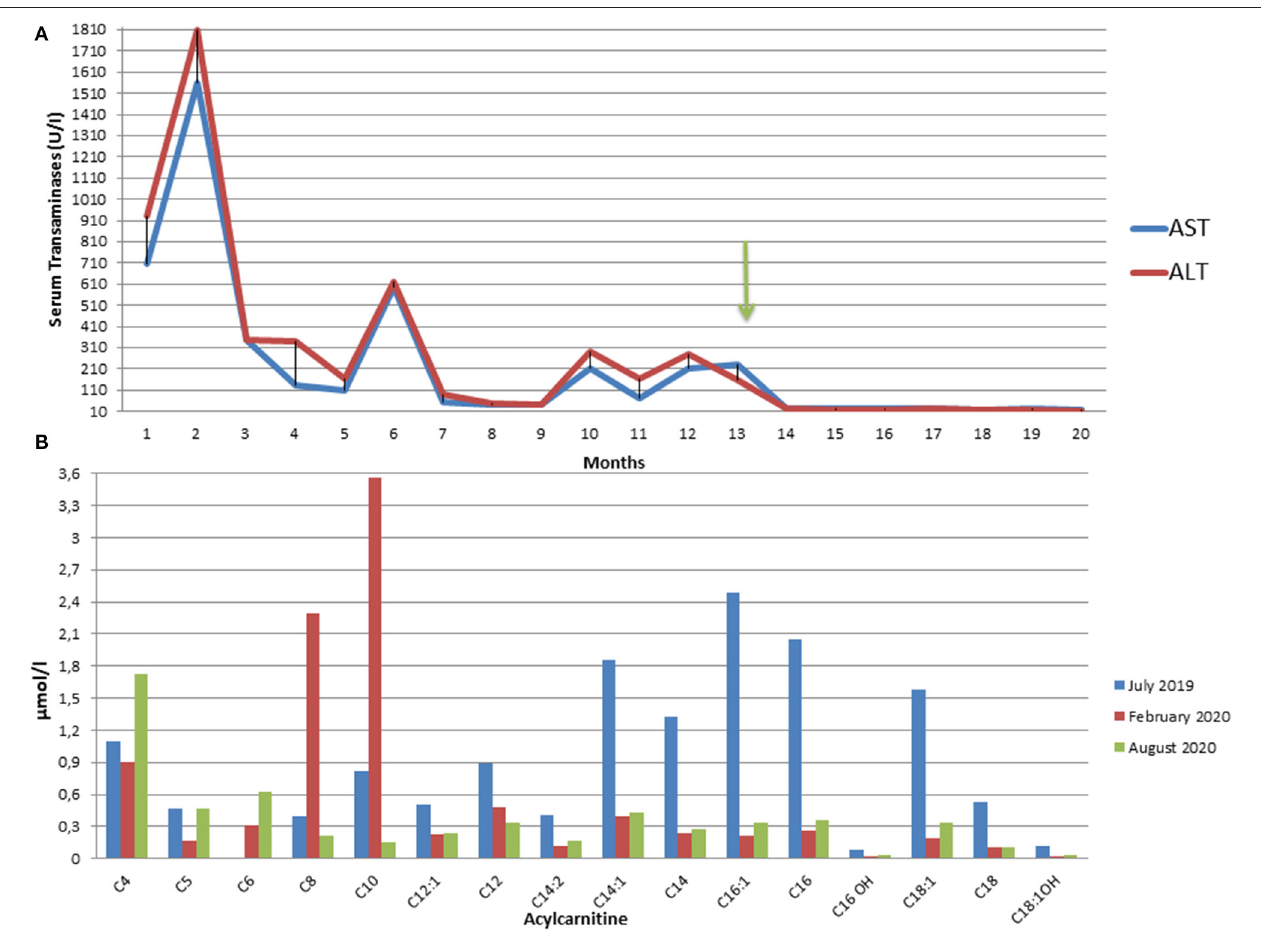
FIGURE 2 | (A) Fluctuating trend of Aspartate (AST) and Alanine (ALT) aminotransferases from the onset of the symptoms to the present moment. The arrow indicates the start of riboflavin treatment. ALT and AST upper normal values are 40 U/L. (B) Plasma C3 to C16 acylcarnitine concentrations in our patient in July 2019 at the onset of symptoms (blue), in February 2020 after three months from the start of therapy (red), and in August 2020 after 9 months of therapy